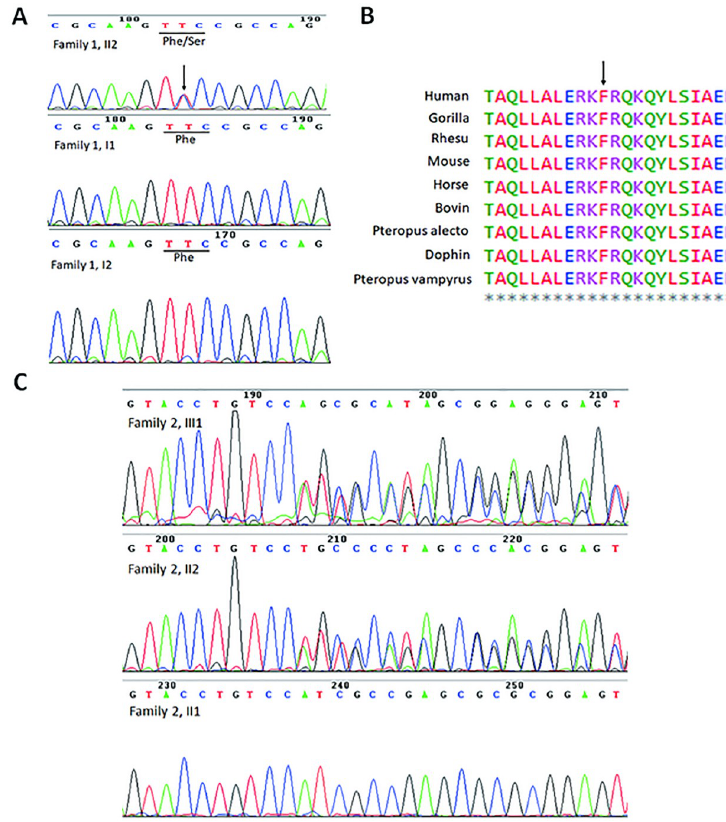
Fig 2. MSX1 mutations isolated from tooth agenesis patients. (A) DNA sequence chromatograms presenting a de novo heterozygous missense mutation c.572T > G in MSX1 identified in family I, compared with wild-type control. (B) Conservation analysis shows that the Phe residue at 191 in Msx1 is conserved across human, gorilla, rhesus, mouse, horse, bovin, pteropus alecto, dophin, pteropus vampyrus. (C) DNA sequence chromatograms showing a heterozygous c.590_594 dup TGTCC mutation identified in family II, compared with